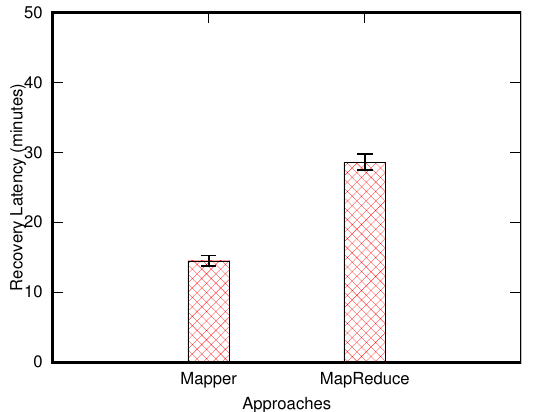
Figure 4. Latency of the recovery process (the table restored in the source cluster is in size of 30